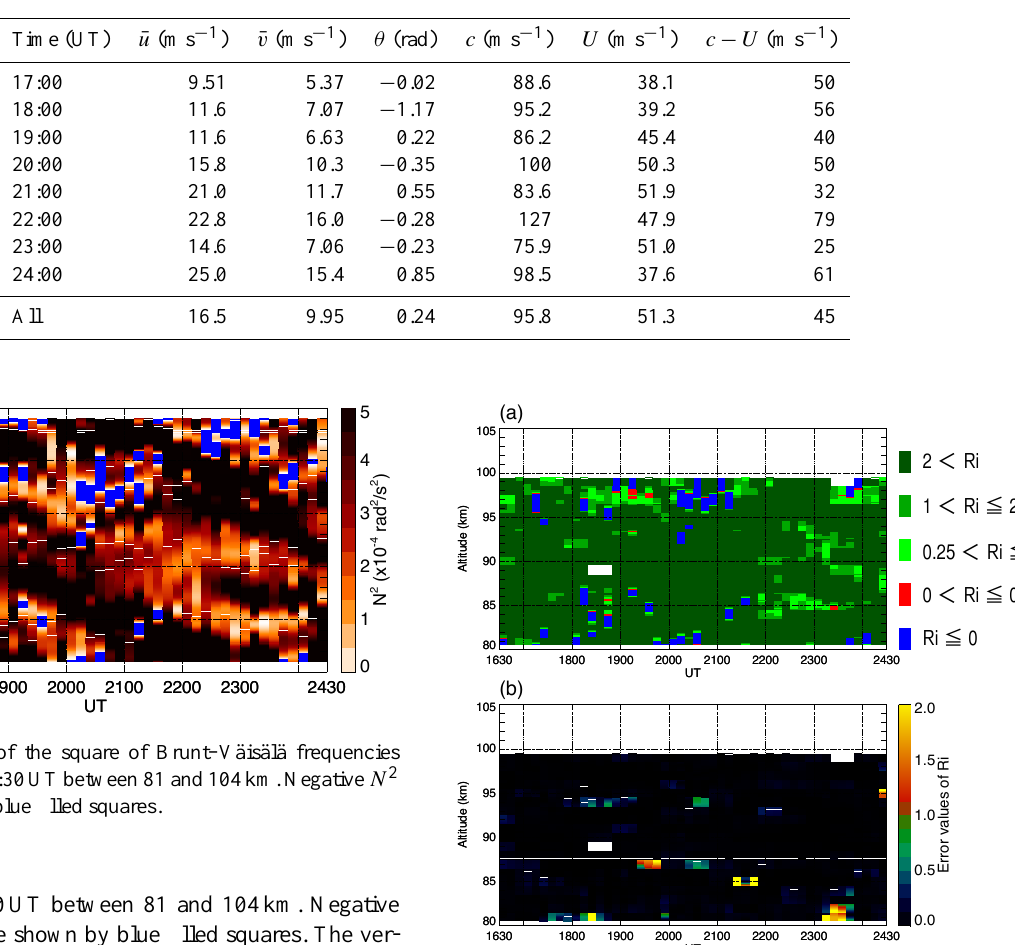
Table 1. Parameters derived with the hodograph method.